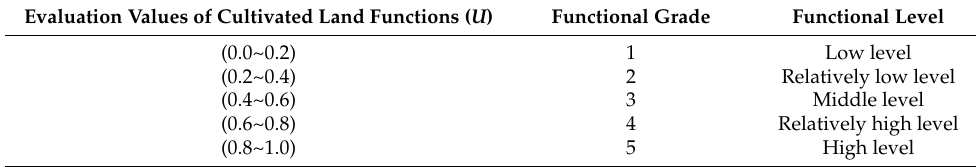
Table 3. Grade and level of evaluation values of the functions of cultivated land.